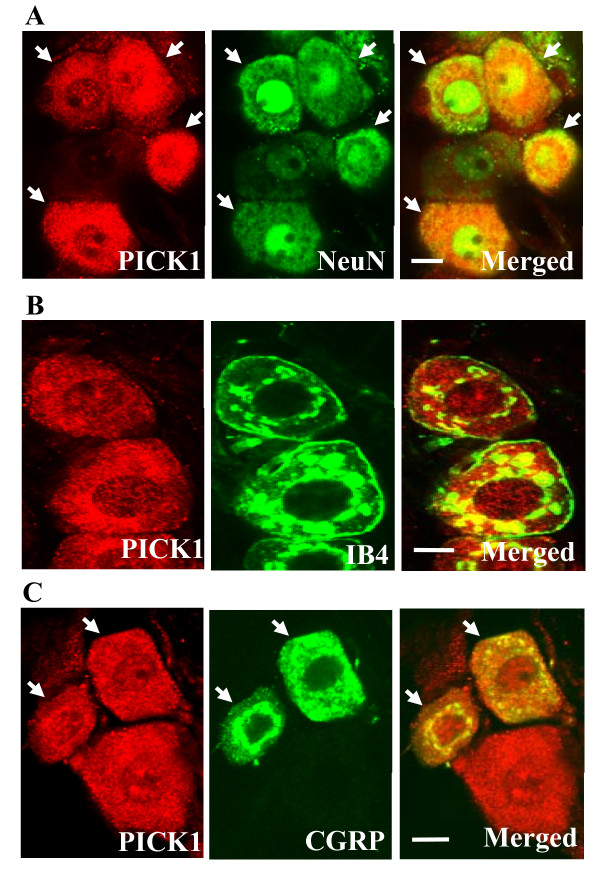
PICK1 immunoreactivity in the DRG neurons and colocalization with IB4 binding and CGRP. Digital images were taken with a confocal laser-scanning microscope. A, Colocalization of PICK1 and NeuN. B, Colocalization of PICK1 and IB4 binding. C, Colocalization of PICK1 and CGRP. Scale bars: 5 μm.